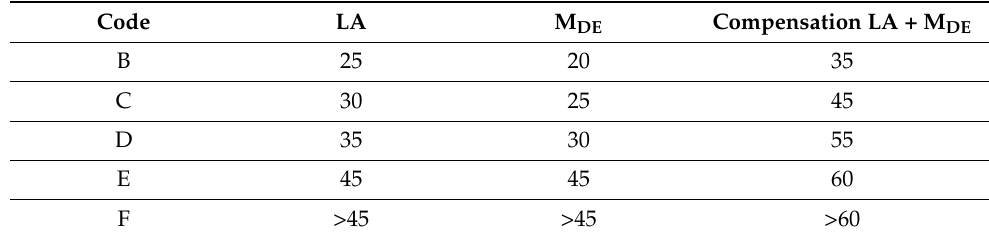
Table 8. Codes of the specified values of the categories for LA and M DE and the LA + M DE compen- sation of aggregates for sub-base, base and binder